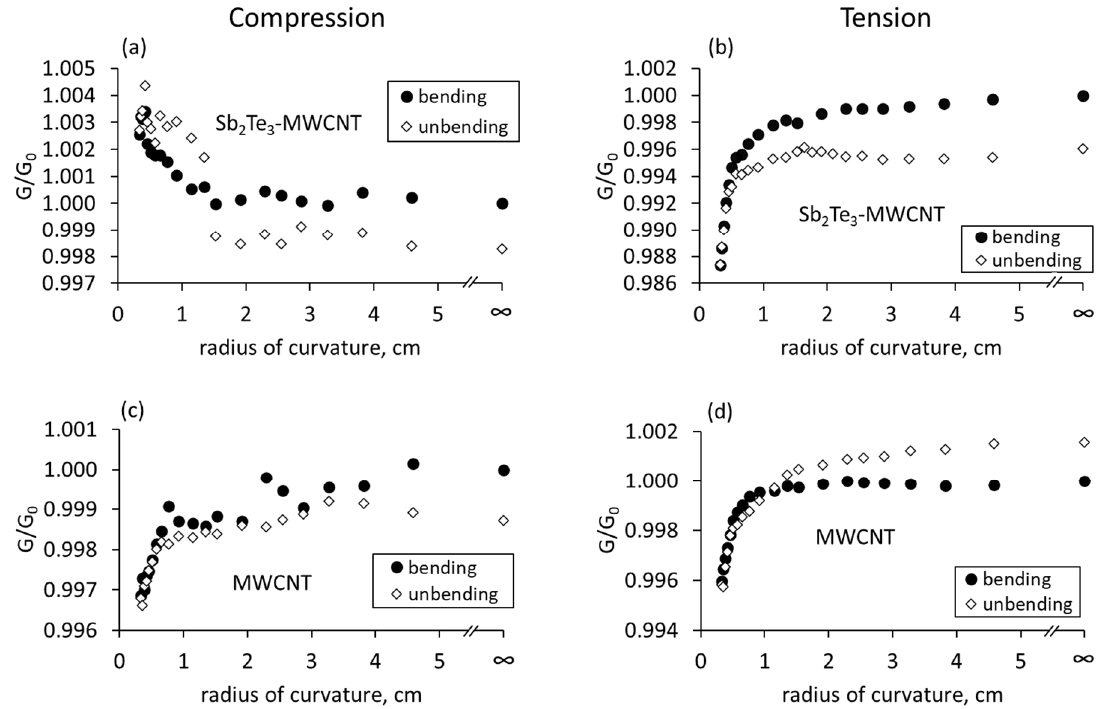
Figure 4. Relative changes in the electrical conductance of free standing Sb 2 Te 3 -MWCNT heterostruc- tures and bare MWCNT networks deposited on polyimide surface vs. its radius of curvature: ( a , c ) compressive stress; ( b , d ) tensile stress. G is the conductance of the bent fl exible fi lm, G 0 is the conductance of the not bent fl exible fi lm.